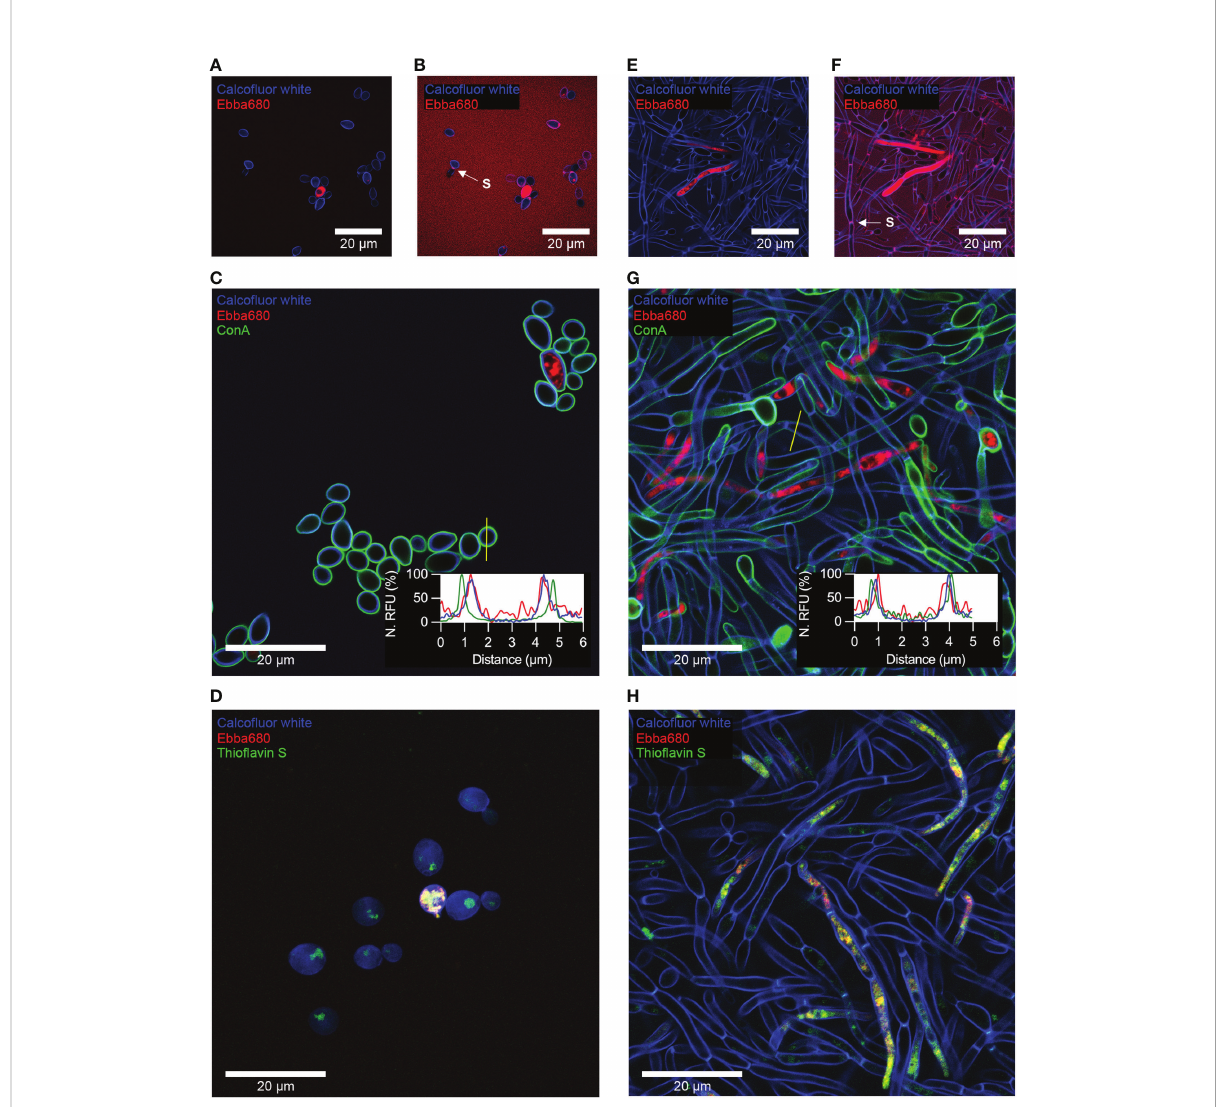
FIGURE 4 Optotracing of yeast cells and bio fi lms using Ebba680. Confocal microscopy of surface attached yeast cells grown from 72h incubation in Ebba680 supplemented SDB, co-stained with (A, B) calco fl uor white, (C) calco fl uor white and ConA and (D) calco fl uor white and Thio fl avin S. (B) Post-imaging enhancement of Figure A to reveal Ebba680 bound cell walls. Confocal microscopy of surface attached bio fi lm grown from 72 h incubation in Ebba680 supplemented RPMI, co-stained with (E, F) calco fl uor white, (G) calco fl uor white and ConA and (H) calco fl uor white and Thio fl avin S. (F) Post-imaging enhancement of Figure E to reveal Ebba680 bound cell walls in the bio fi lm. Septae, dividing connected cells in Figures B and F are indicated by an arrow and denoted ‘ S ’ . The embedded graphs in C and G show normalized fl uorescence intensities of Ebba680, calco fl uor white and ConA plot as a line pro fi le. Yellow lines show the location of the line pro fi le. Representative images of three independent experiments are